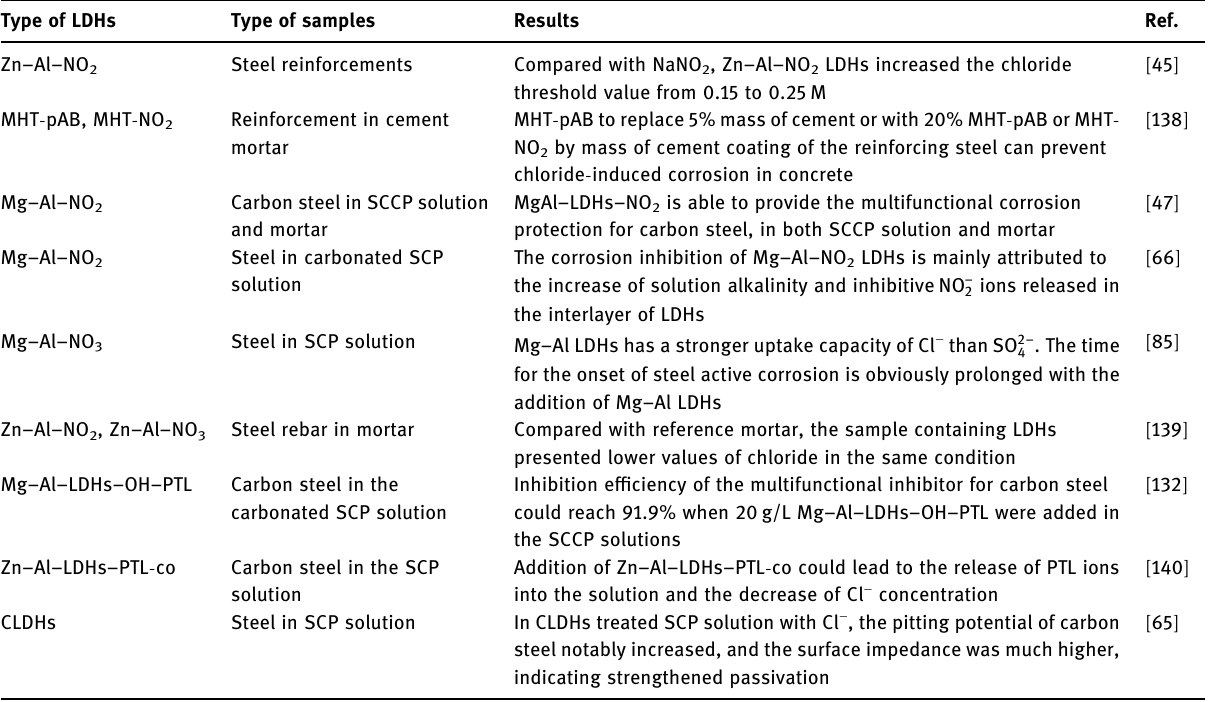
Table 3: Summary of reinforced concrete with LDHs Type of